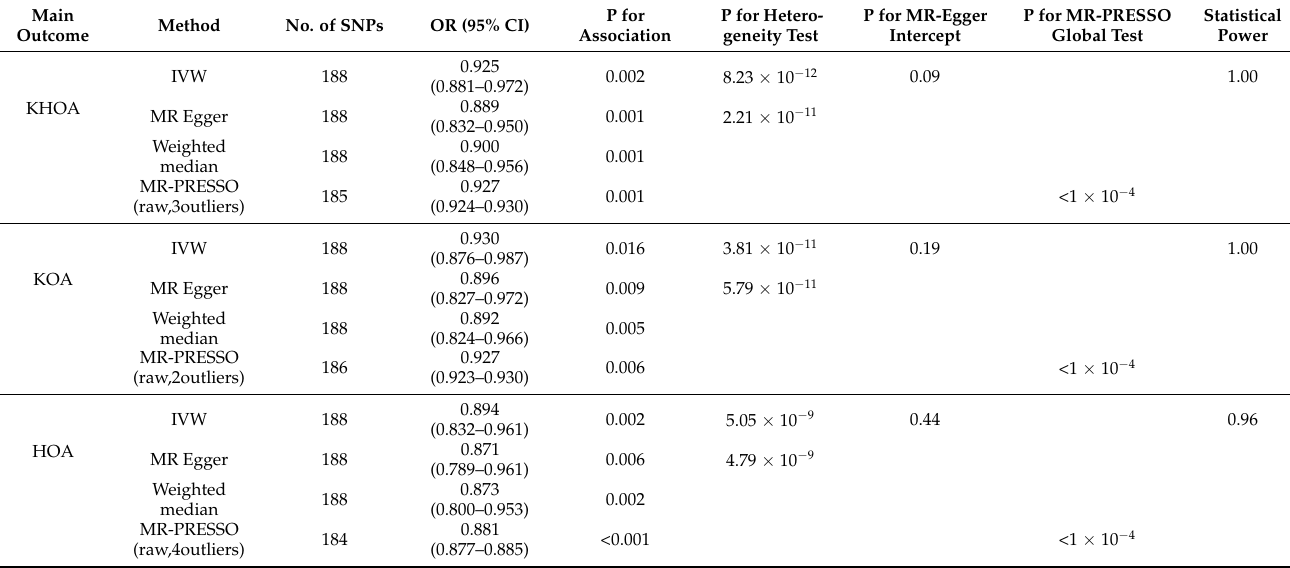
Table 2. Associations of genetically predicted APOB with OA risks in MR